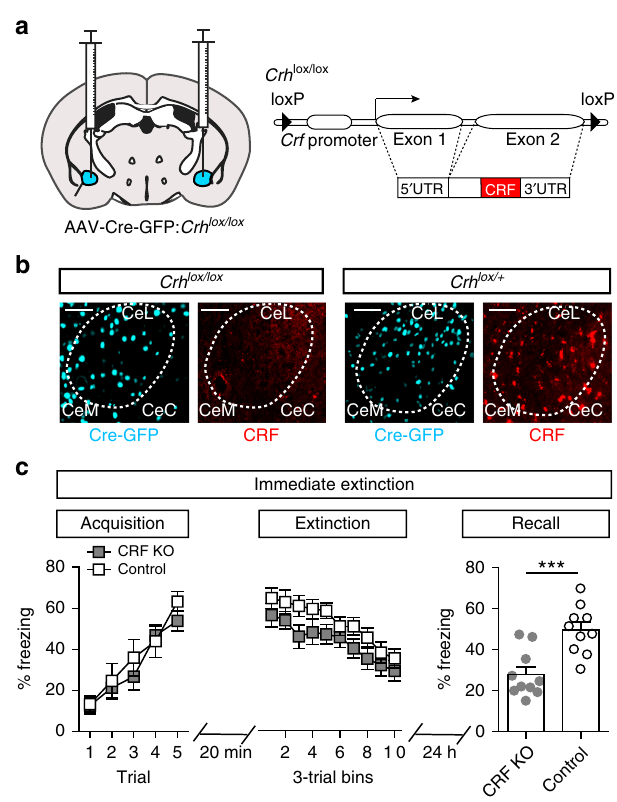
Fig. 2 Inactivation of Crh in the CeA attenuates the immediate extinction de fi cit. a Schematic of AAV1-Cre-GFP injection into the CeA of Crh lox/lox mice and corresponding loxP- fl anked Crh allele. b Histological veri fi cation of Cre-GFP expression in the CeA and loss of CRF peptide in Crh lox/lox injected mice. Scale bar: 100 μ m. c Acquisition (left) and extinction (middle) are not altered by Crh inactivation in the CeA, but fear extinction recall (right) is signi fi cantly enhanced relative to Crh lox/ + mice injected with AAV1-Cre- GFP (Unpaired Student ’ s t -test, *** P < 0.001; n = 10/group). Data are presented as mean ±